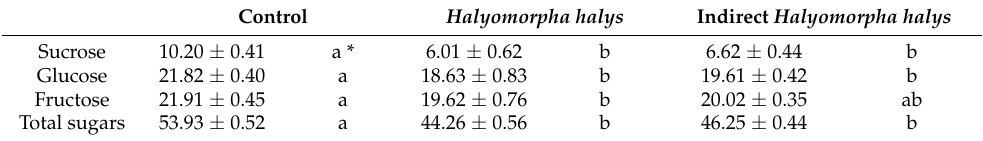
Table 1. Individual and total sugar content (g/kg FW, mean ± SE) in strawberry fruit. Control